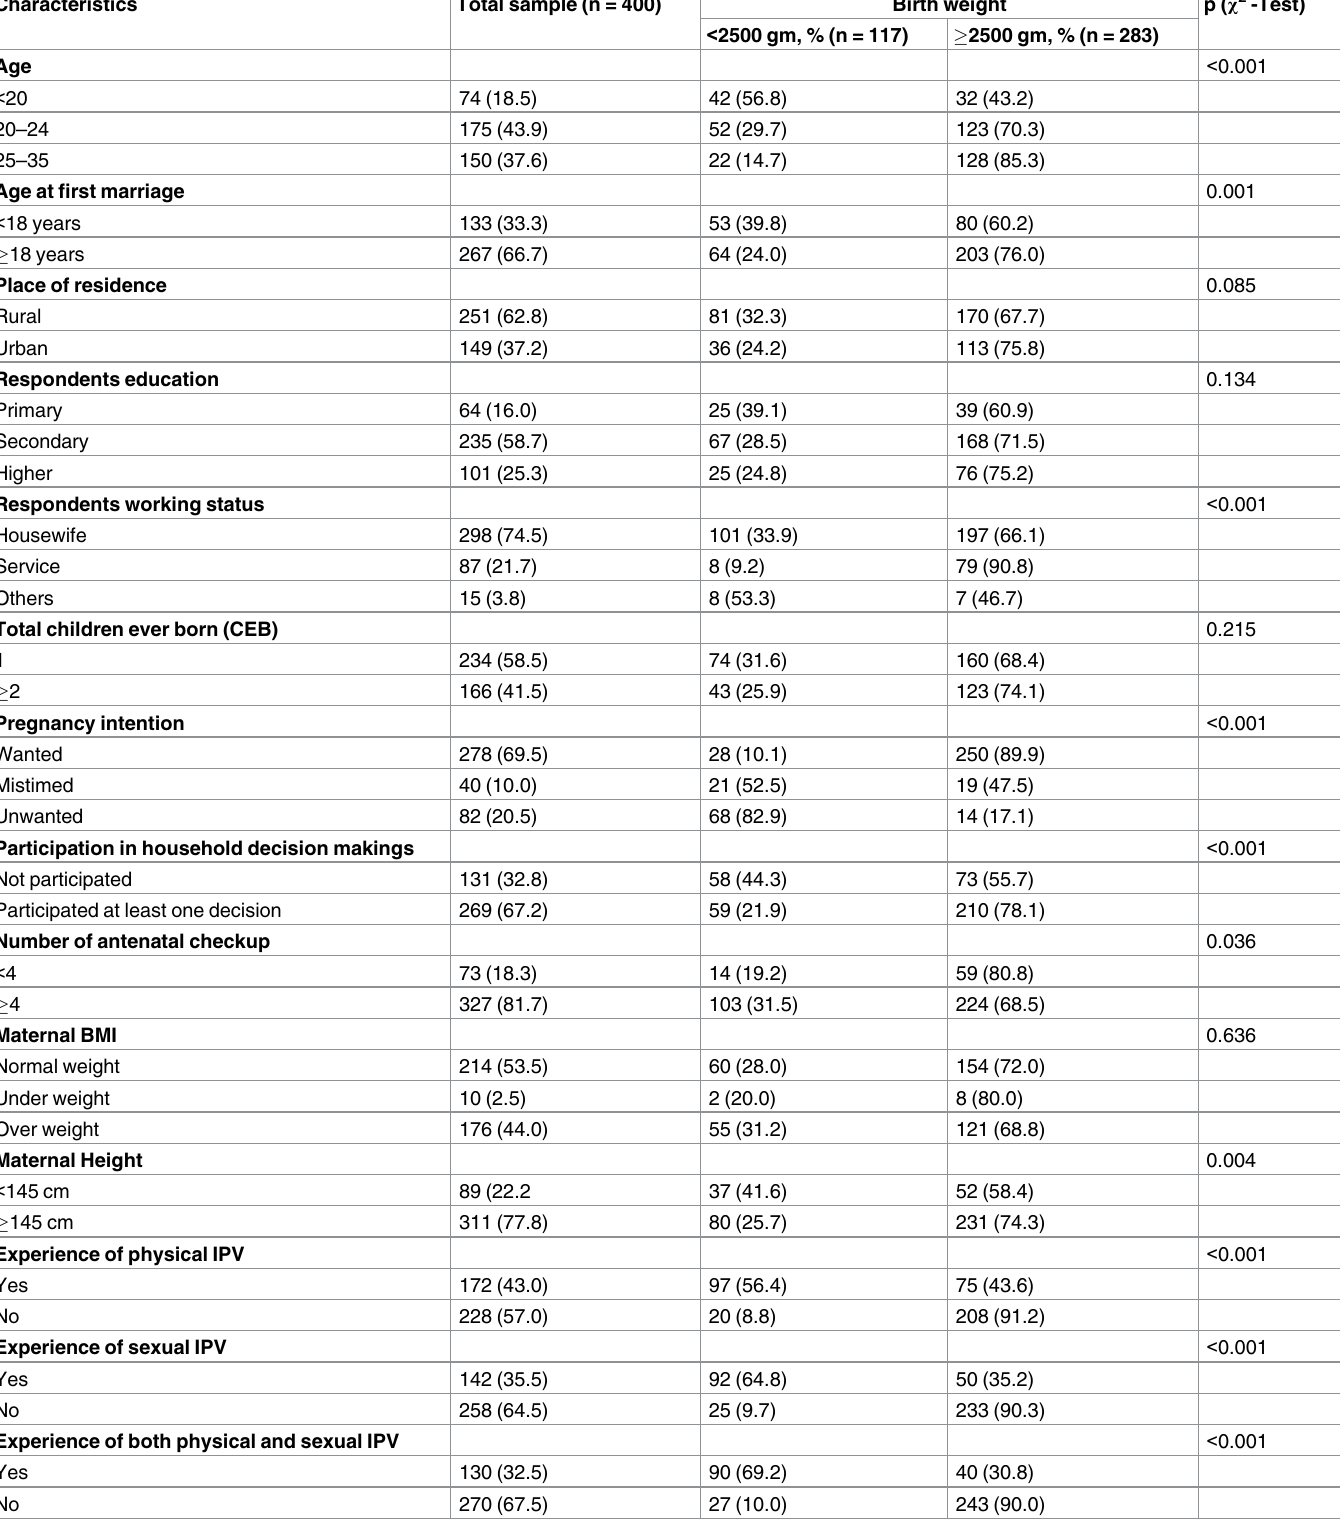
Table 1. Association of selected variables with birth weight a .